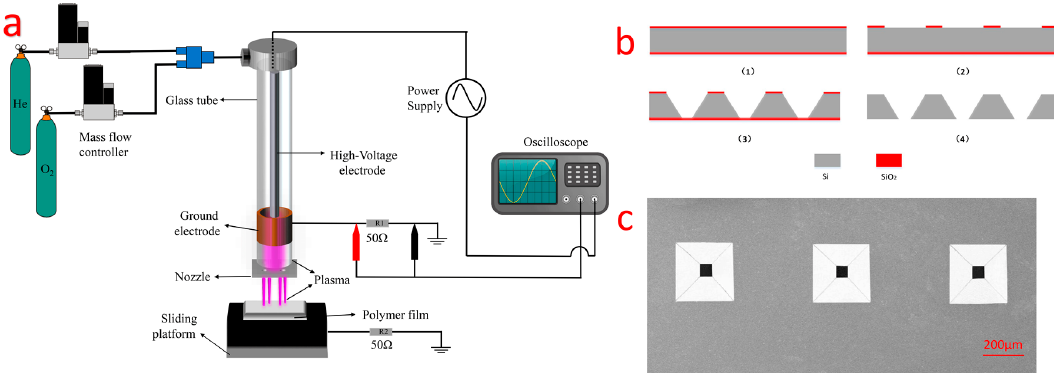
Figure 1. ( a ) The schematic diagram of the atmospheric pressure plasma microjets array system maskless etching process; ( b ) fabrication sequence of a Micro Electro Mechanical Systems (MEMS) nozzle; ( c ) scanning electron microscope (SEM) image of single hole on the nozzle, the upper and lower diameter of the hole were around 262 µ m and 50 µ m, respectively.